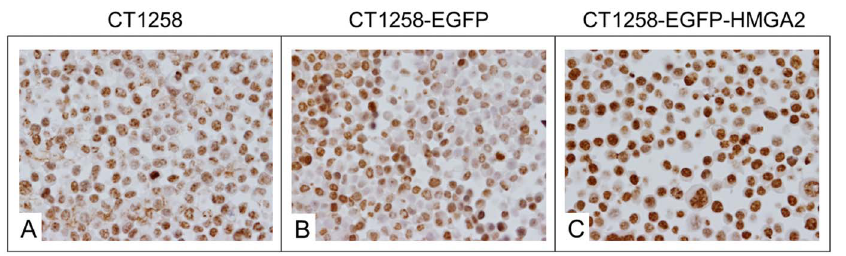
Figure 2. Immunocytochemical staining. A: Native CT1258 cells, B: CT1258-EGFP cells, C: CT1258-EGFP-HMGA2 cells. Approximately 50% of the native CT1258 cell line and of CT1258-EGFP cells showed a HMGA2-positive nuclear labelling. In approximately 70–80% of CT1258-EGFP-HMGA2 cells, a strong and exclusively nuclear labelling for HMGA2 was detectable.